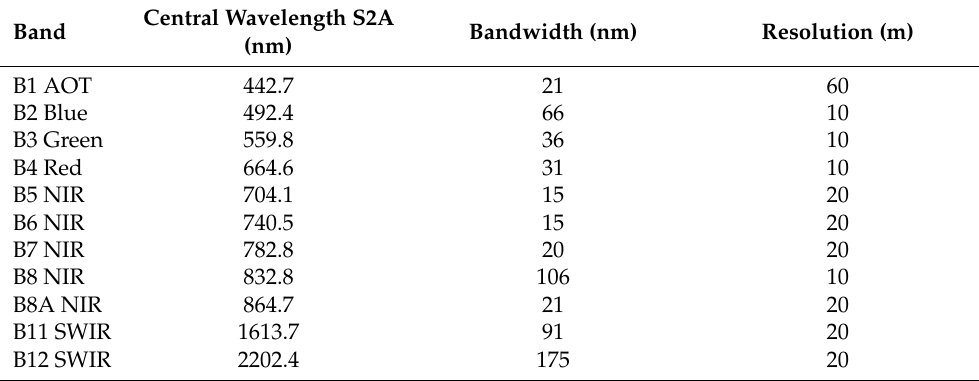
Table 2. MSI spectral bands selected for classification, including Visible (VIS), Near Infra-Red (NIR) and Short Wave Infra-Red